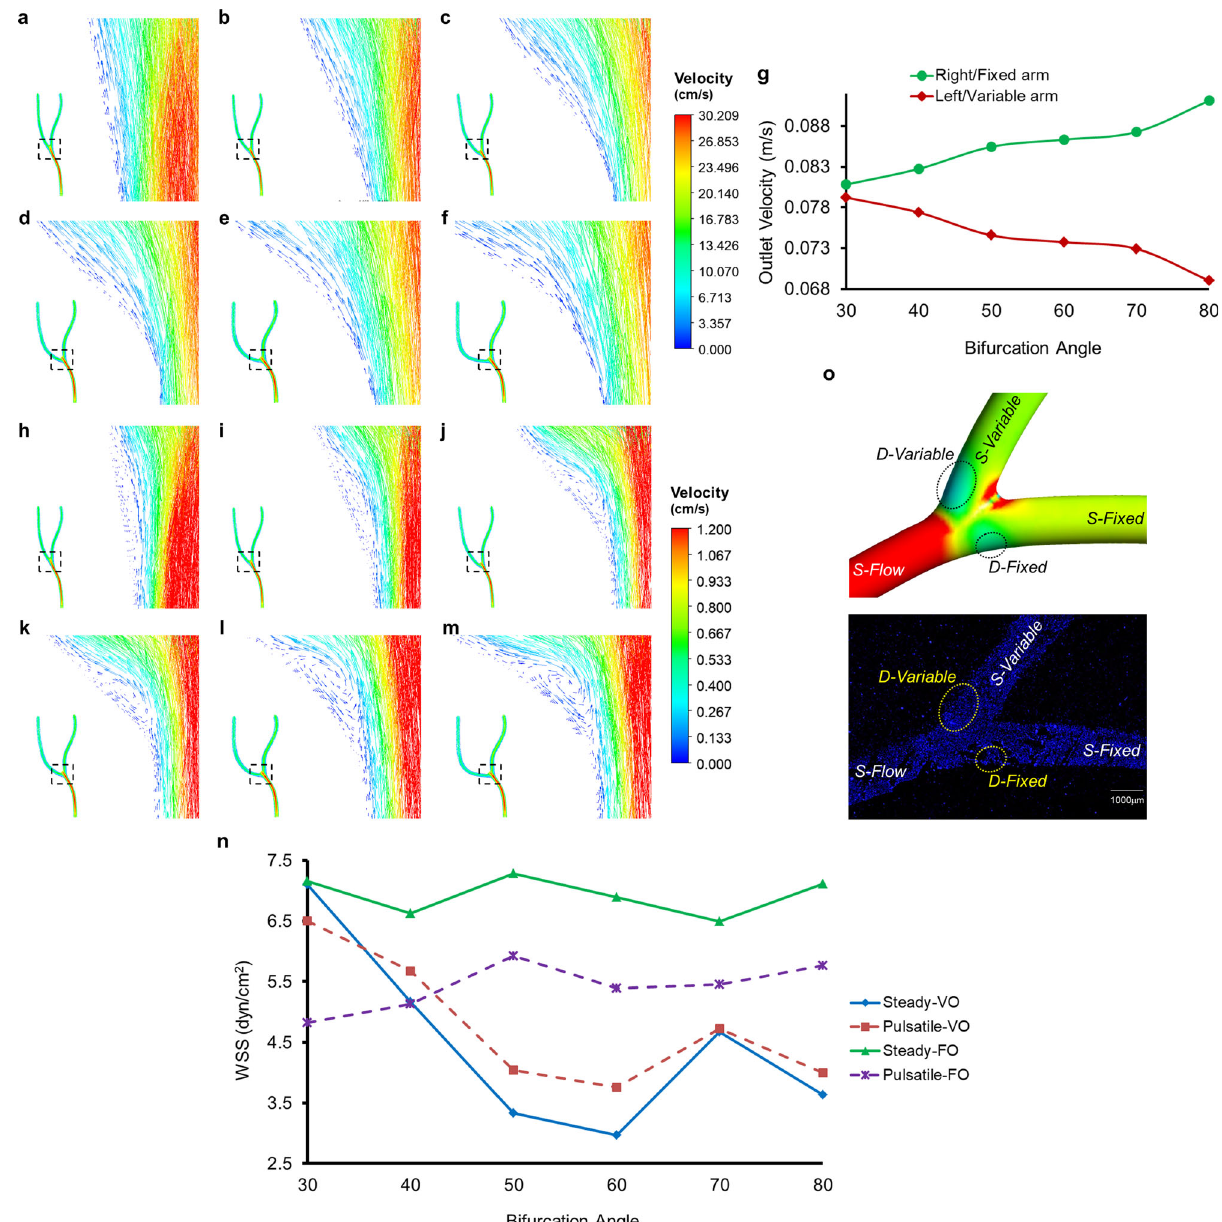
Fig. 2 Angular differences at the coronary artery branching points cause turbulent fl ow patterns, perturb velocity dispensation thereby forming WSS gradient. a – f Velocity vectors on steady-state simulations of 30° ( a ), 40° ( b ), 50° ( c ), 60° ( d ), 70° ( e ) and 80° ( f ) bifurcation angles. g Outlet fl uid fl ow velocities (m/s) obtained from right/ fi xed arm and left/variable arm of human coronary artery with 30, 40, 50, 60, 70 and 80° branching points. h – m Velocity vectors of pulsatile-rigid simulations in coronary artery with bifurcation angle 30° ( h ), 40° ( i ), 50° ( j ), 60° ( k ), 70° ( l ), and 80° ( m ) at t = 0.415 s. n WSS or TAWSS in the D-Flow regions variable and fi xed for steady-state and pulsatile-rigid simulations. o Based on the simulation studies performed on a bifurcated human right-coronary artery, various zone were identi fi ed and de fi ned across the vessel. Inlet arm: steady laminar fl ow (S-Flow), right/ fi xed outer wall (bifurcation): disturbed fl ow in fi xed arm (D-Fixed), left/variable outer wall (bifurcation): disturbed fl ow in variable arm (D-Variable), steady laminar fl ow outlet arms: right/ fi xed arm (S-Fixed) and left/variable arm (S-Variable). Similar regions were identi fi ed and used for in vitro microscopic analysis EC exposed to shear stress in the